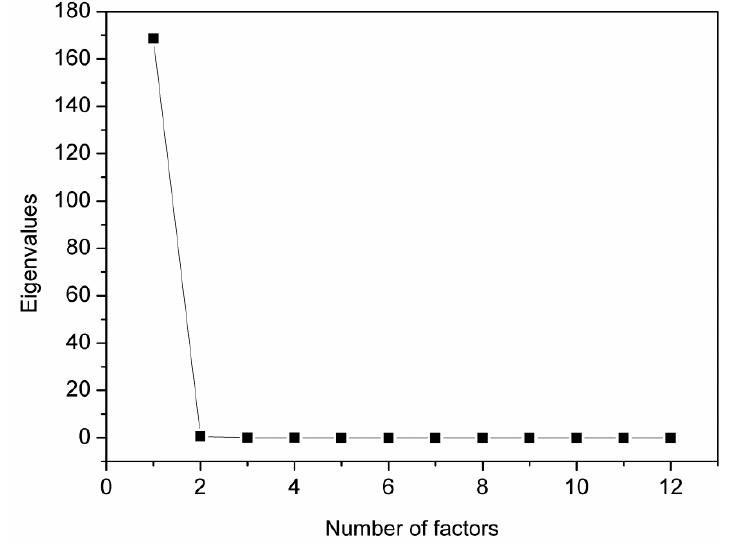
Figure 7. Eigenvalues for 12 factors (12 spectra of PUR-PIR foams).